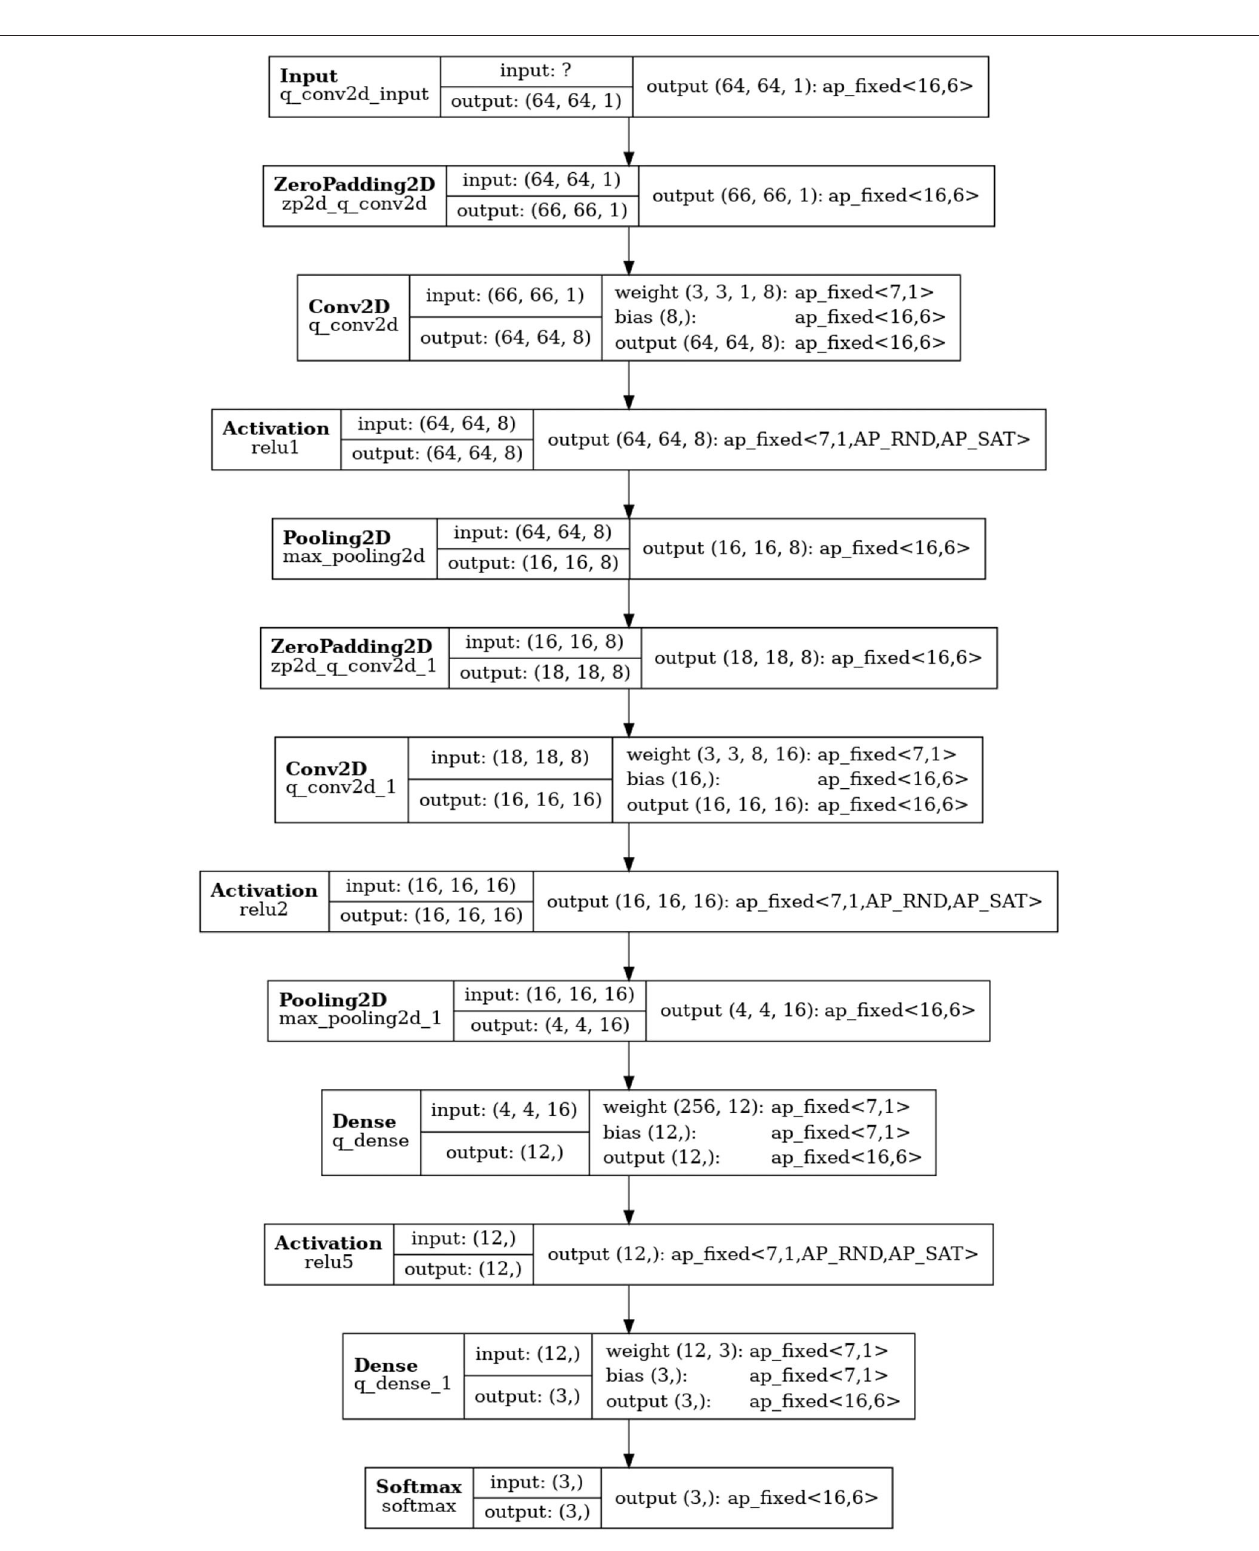
FIGURE 6 | Precision configuration of layers in Q-CNN02-DS-OP . The precision configuration of the reference CNN02-DS-OP can be found in Figure 7 . Note that FPGA resource utilization is generally reduced with smaller ap_fixed values.